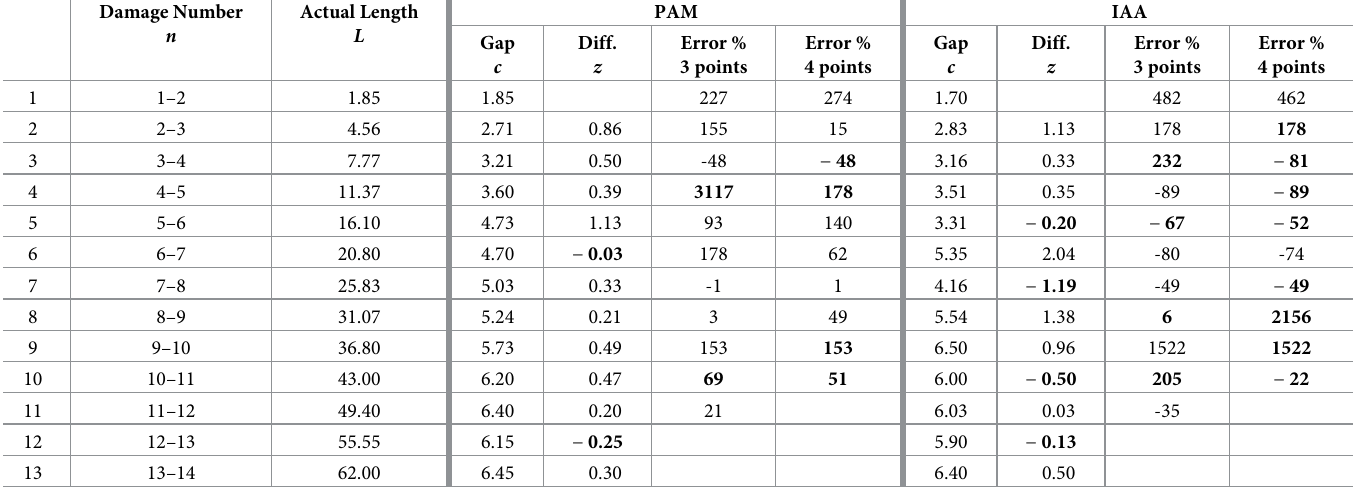
Table 4. Apocryphal Psalms , 11Q11.